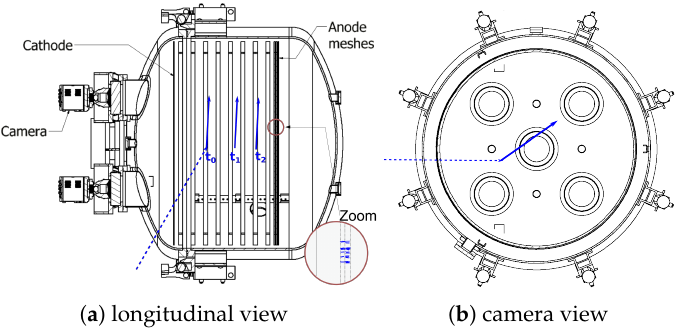
Figure 1. Cross-sectional view of the HPTPC through ( a ) the plane parallel to the drift field E and ( b ) the plane perpendicular to E . A particle (dotted line) scatters on an atom or molecule in the gas at the time t 0 , ejects a charged particle from the nucleus, which, in turn, ionizes gas atoms along its trajectory (arrow, Figure ( a )). These ionization electrons are moved by E towards the anode meshes and they are eventually amplified. The positions of these ionization electrons as they drift are labelled t 1 and t 2 . Photons that are produced during the amplification are then imaged by cameras and provide the 2D projection of the interaction (Figure ( b )), the zoomed inlet in ( a ) illustrates where avalanches form and the photons are